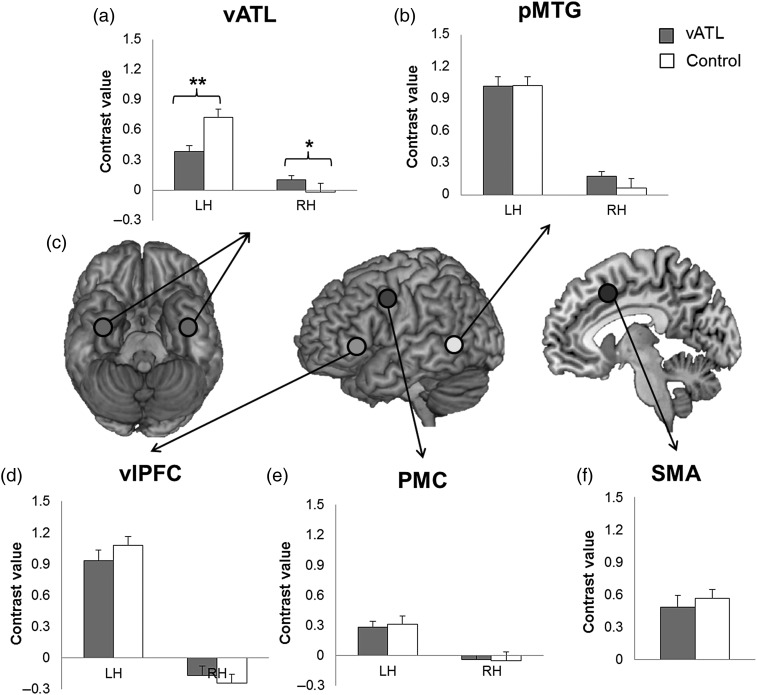
Effects of cTBS of the synonym–number judgment contrast for the vATL stimulation (gray color bar) and the control stimulation (white color bar) in ROIs (a,b,d–f). (c) Locations of ROIs. Error bar represents standard errors. *P< 0.05, **P< 0.01 (P values were corrected by FDR procedure).